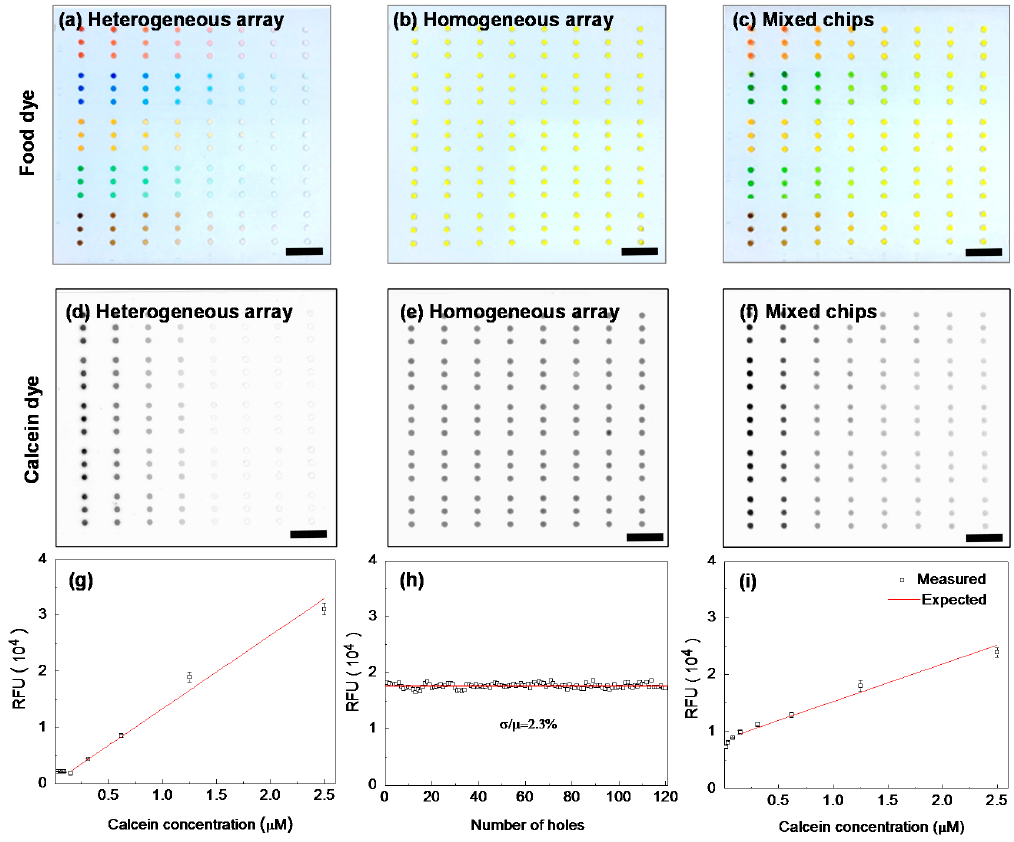
Figure 3. Validation of the 3D microfluidic device with plain food dyes and fluorescent calcein dye. ( a – c ) Food dye validation. The image shows the heterogeneous array chip consisting of different colors ( a ); homogeneous array chip of a single color ( b ); and the mixed chips ( c ). ( d – f ) Fluorescent calcein dye validation. The scanning images show the heterogeneous array chip ( d ); homogeneous